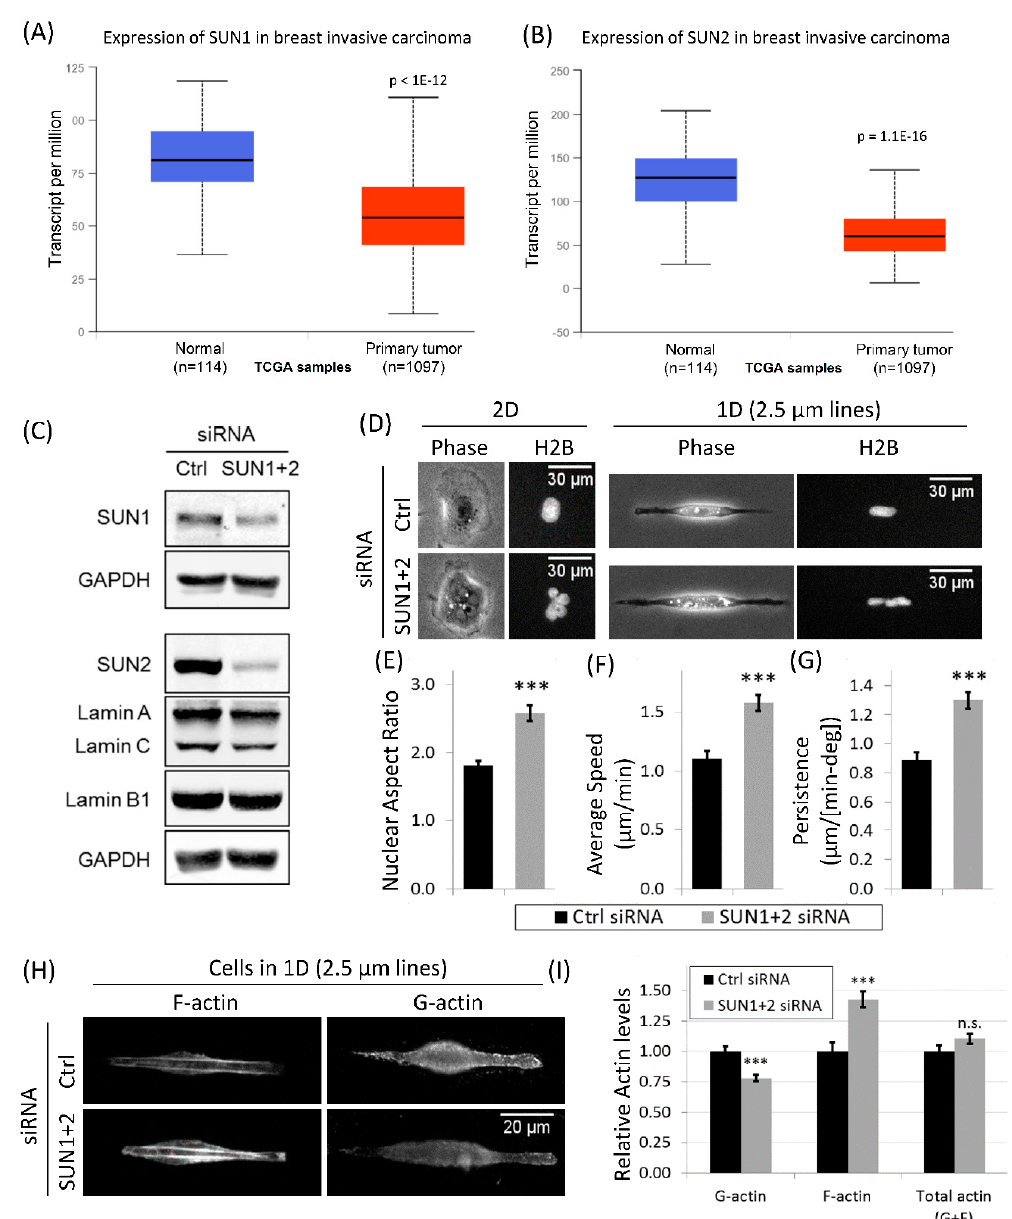
Figure 6. SUN1 and SUN2 downregulation in breast cancer patients; LINC complex disruption increases actin polymerization and tumor cell motility in 1D, but not in 2D. ( A ) Box plot analysis shows downregulation of SUN1 in primary breast tumor (n = 1097) versus normal breast tissue ( n = 114) derived from RNA-Seq expression data from TCGA samples. ( B ) Box plot analysis shows downregulation of SUN2 in primary breast tumor ( n = 1097) versus normal breast tissue ( n = 114) derived from RNA-Seq expression data from TCGA samples. ( C ) Western blots showing SUN1 and SUN2 knockdowns in SUN1 siRNA + SUN2 siRNA treated tumor cells. Blots were also stained with Lamin A/C and Lamin B1 antibodies to check Lamin levels after SUN1 + 2 KD. ( D ) Images showing cellular (phase panels) and nuclear (GFP-H2B panels) morphologies after SUN1 + 2 KD in 1D (2.5 µm micropatterned line) and 2D. Note the multi-lobular nuclear morphology after SUN1 + 2 KD in both 1D and 2D. ( E – G ) Quantifications of nuclear aspect ratio ( E ), average tumor cell speed ( F ) and tumor cell persistence ( G ) after SUN1 + 2 KD in 1D. Data plotted as mean ± SEM, n = 22 cells (Ctrl siRNA) and 17 cells (SUN1 + 2 siRNA), *** p value < 0.001. ( H ) Images showing phalloidin (F-actin) and G-actin staining in control and SUN1 + 2 KD cells migrating in 1D. Images were acquired at the same exposure time and ND filter settings for each channel. ( I ) Quantifications of whole cell F-actin, G-actin, and total actin (F-actin + G-actin) levels in control and SUN1 + 2 KD cells migrating in 1D. Data normalized to Ctrl siRNA condition and shown as mean ± SEM, n = 32 cells (Ctrl siRNA) and 36 cells (SUN1 + 2 siRNA), *** p value < 0.001, n.s. not significant.